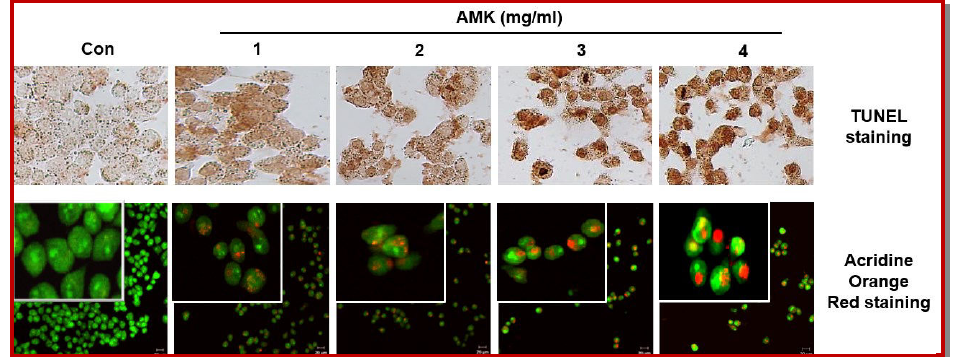
Figure 2: A. macrocephala (AMK) has dual induction effect to apoptosis and autophage in a dose-dependent manner. Apototic cell death and autophagosome formation was detected after 24 hours treatment of A. macrocephala using TUNEL staining (upper pan- el) acridine orange red staining (lower panel). Microscopic photos were taken at 100x magnification